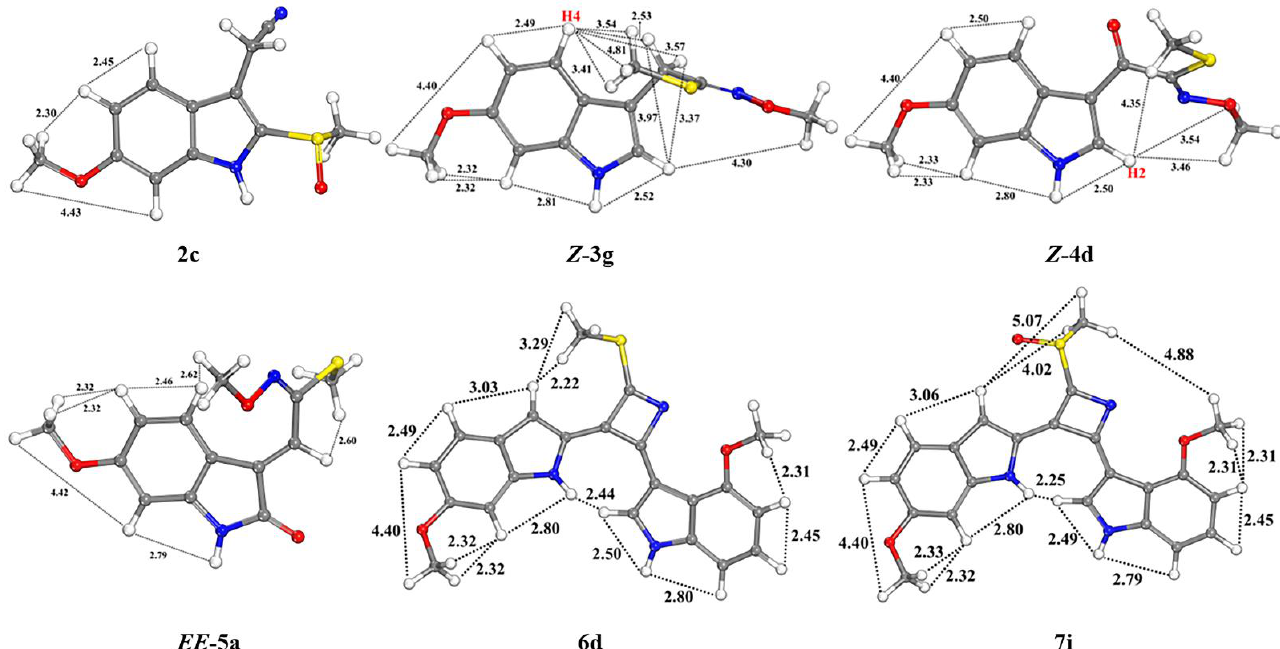
Figure 6. The most stable conformers due to the lowest relative energy of compounds 2 – 7 , based on the DFT calculation at B3LYP/6-31g (d,p) level in the DMSO for compounds 3 – 6 , and MeOH for compounds 2 and 7 (see Supplementary materials B: Computational studies).